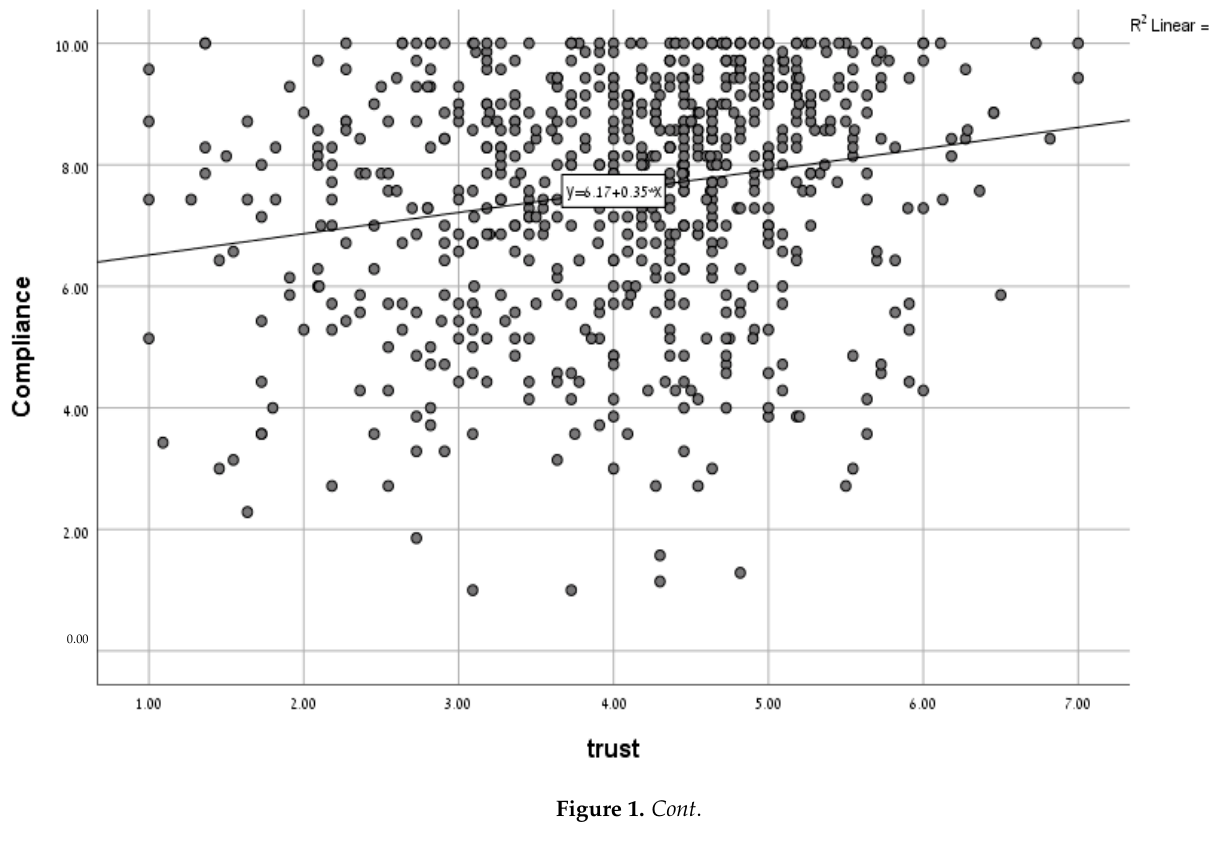
Table 3. Means and standard deviations for trust in various state agencies (1–7).